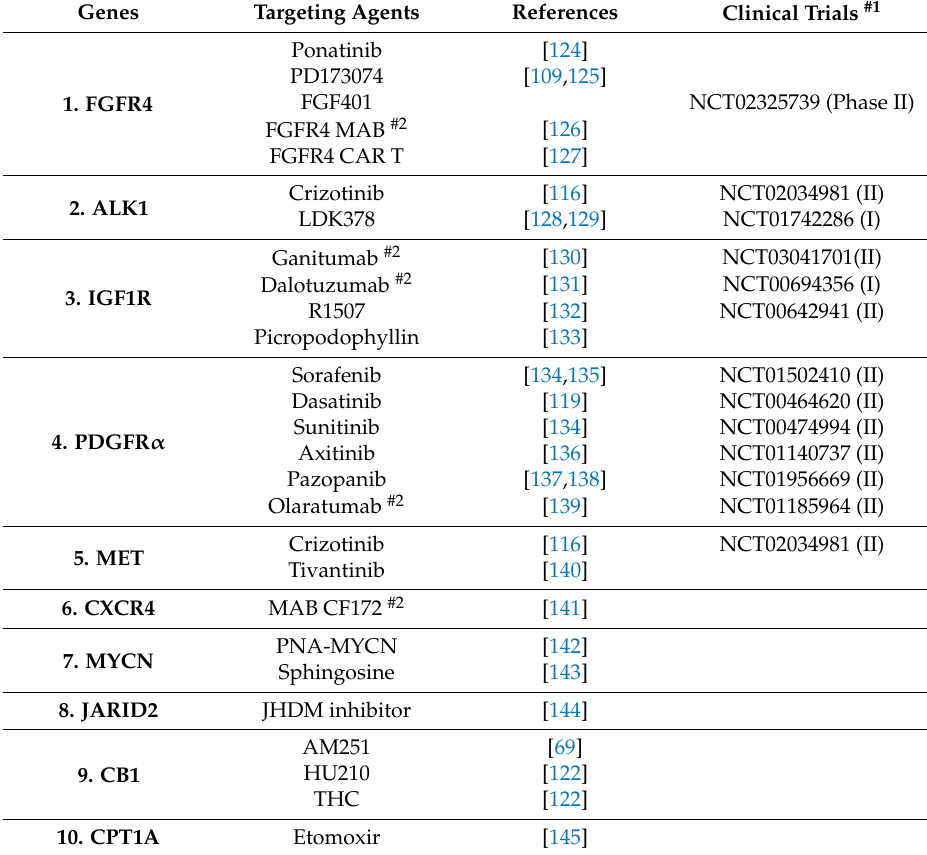
Table 3. PAX3-FOXO1 downstream targets and specific agents that could be potentially explored for treatment of FP